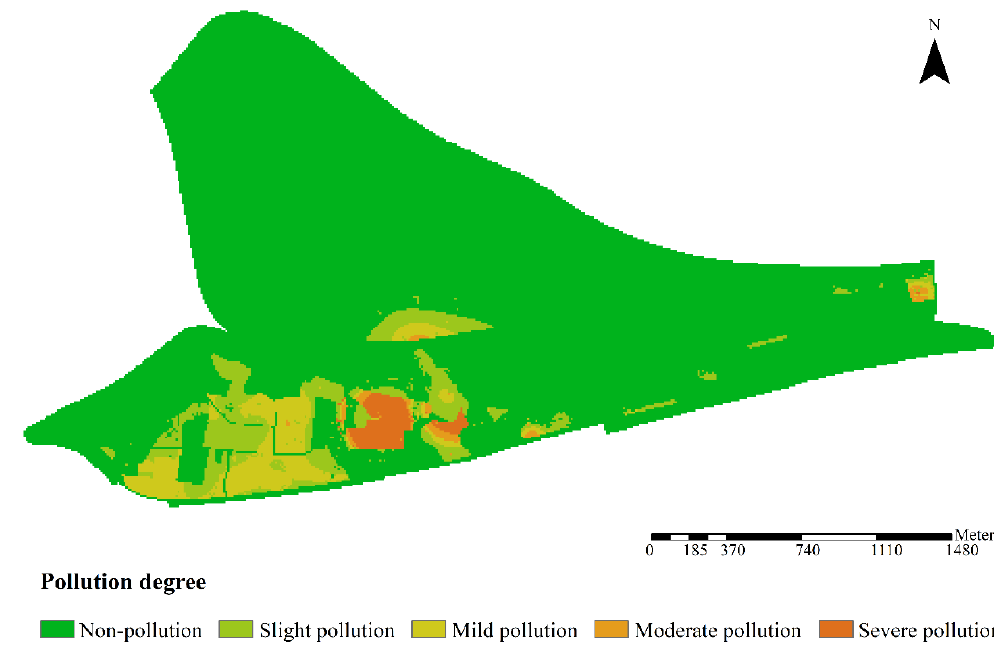
Figure 6. Evaluation of Hg pollution in the study area.